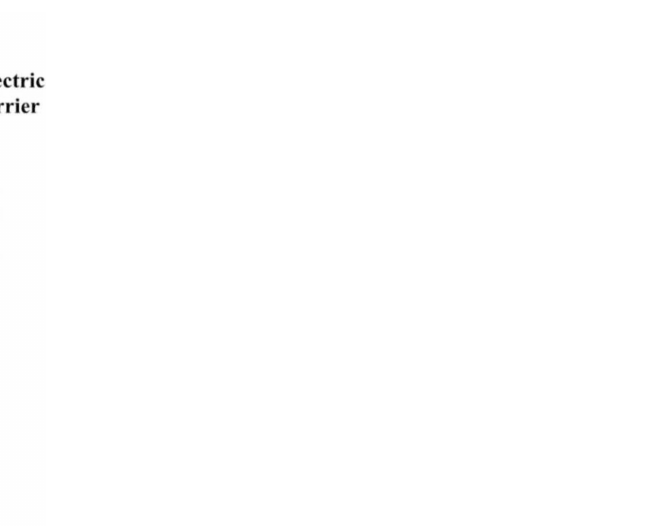
Figure 6. Electro-Fenton-assisted porous carbon–carbon nanotubes–polyvinyl butyral hollow fiber membrane loaded with Fe 2+ proposed to control fouling caused either by cell deposition or ex- tracellular organic matter (EOM) during microalgae harvesting. Reprinted with permission from Zheng et al. [90], Copyright 2021, with permission from